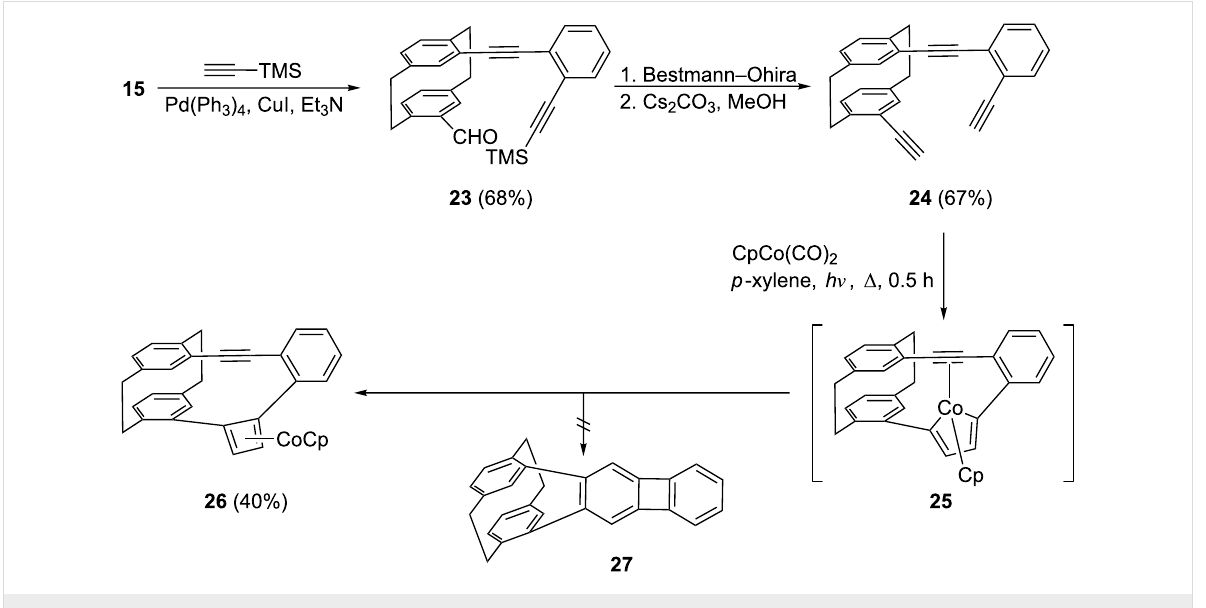
Scheme 8: An attempt to prepare a biphenylenophane.